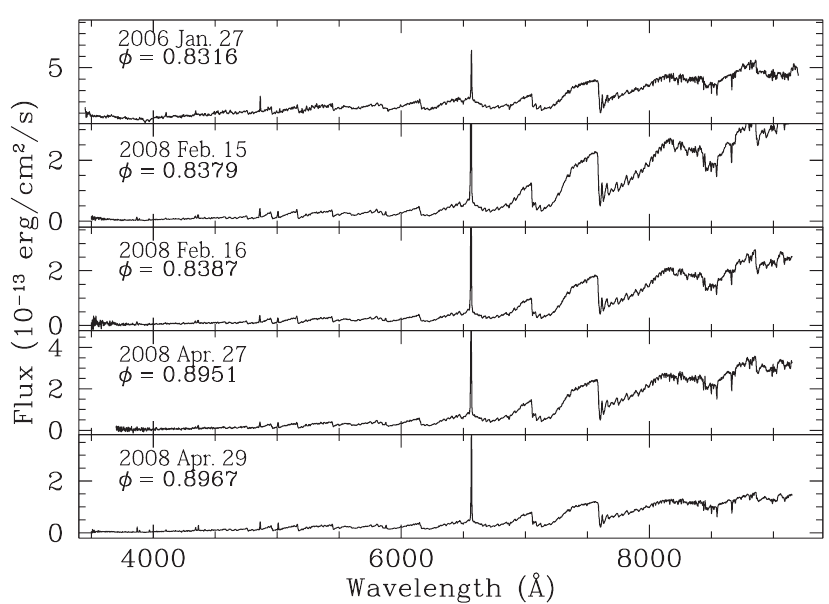
Fig. 4. The spectra of BX Mon during phases